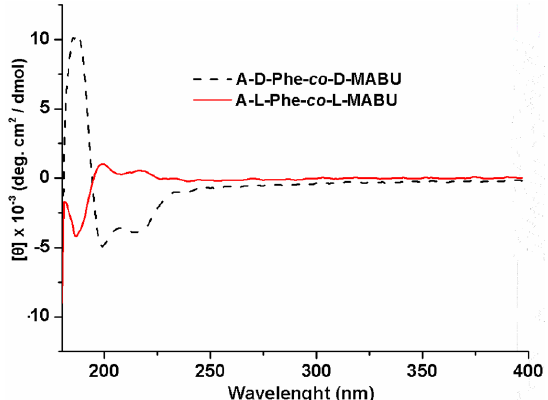
Figure 4. Circular dichroism spectra of copolymers A-D-Phe- co -D-MABU (- - - ) and A-L-Phe- co -L-MABU (——) in distilled water, in various conformations.